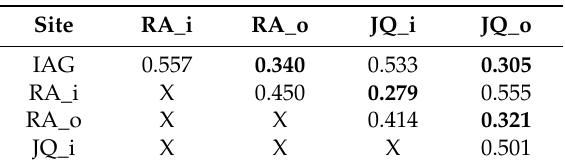
Table 3. Coefficient of divergence values for the different profiles analyzed, considering a similarity threshold of 0.3, as proposed by Kong et al.